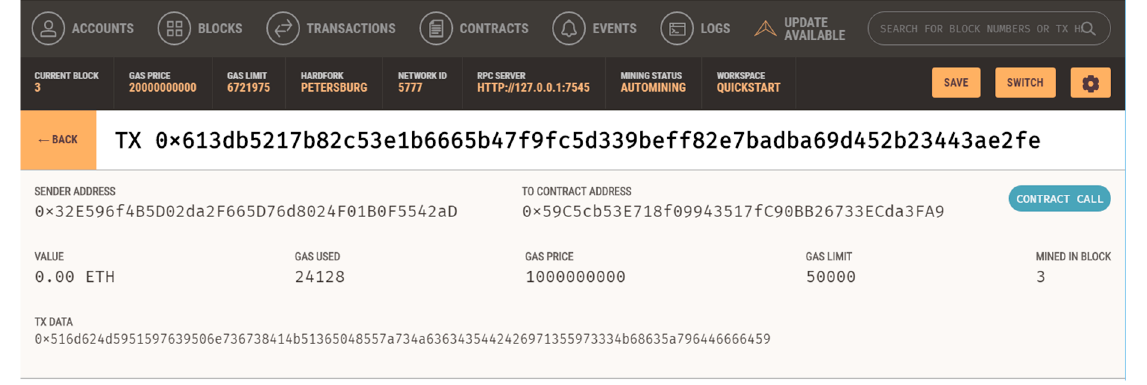
Figure 13. IPFS hash transaction.